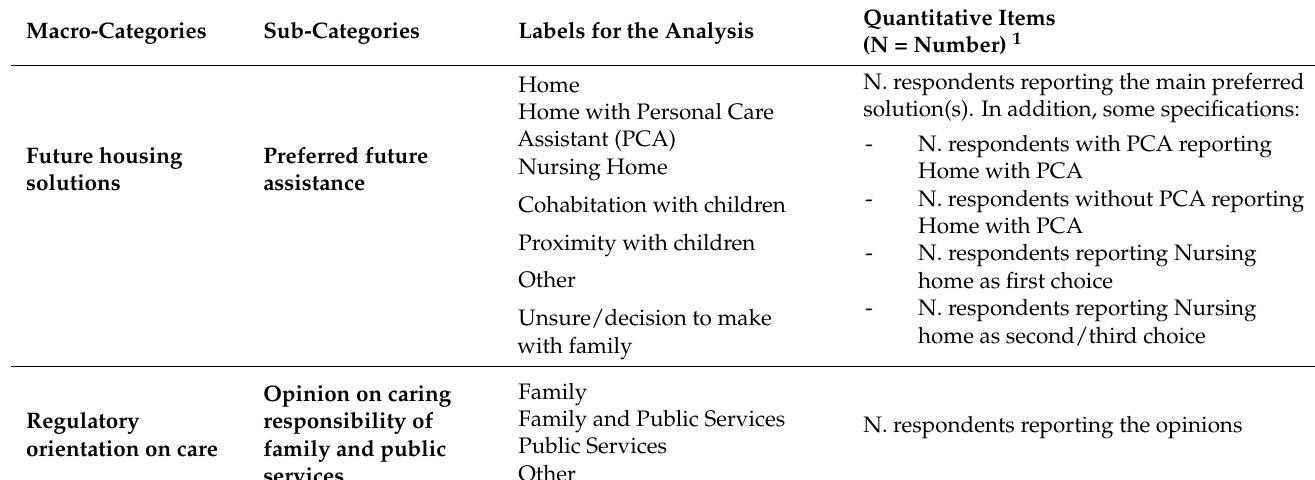
Table 1. Overview of macro-categories, sub-categories, labels, and quantitative